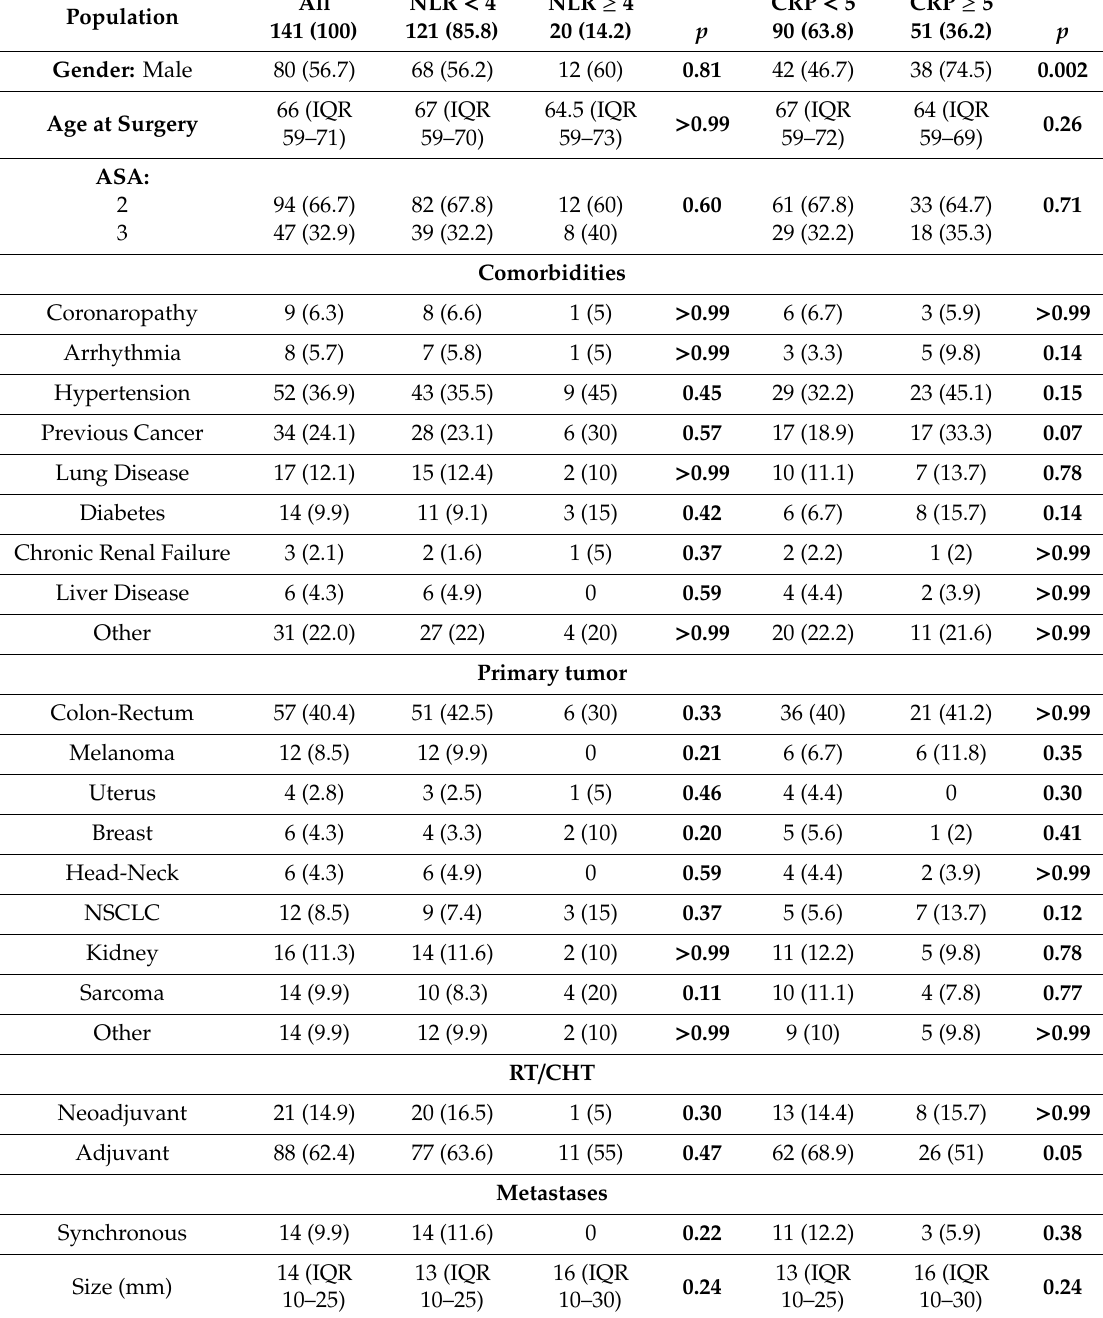
Table 1. Patient and tumor